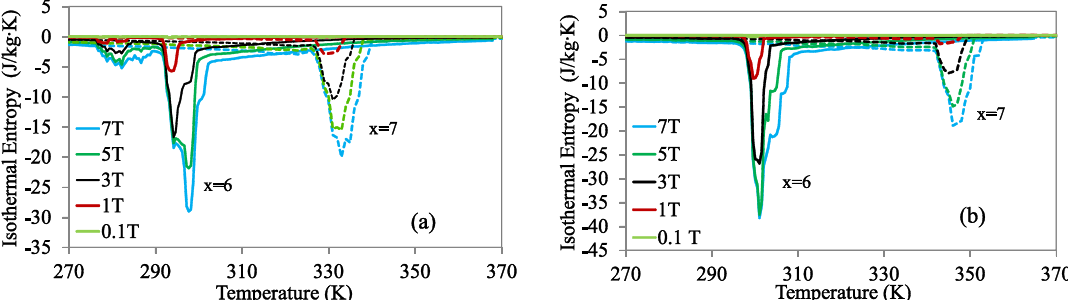
Figure 8. Isothermal entropy change up to different magnetic fields as a function of temperature on cooling ( a ) and heating ( b ) for alloys x = 6 (solid lines) and x = 7 (dashed lines).